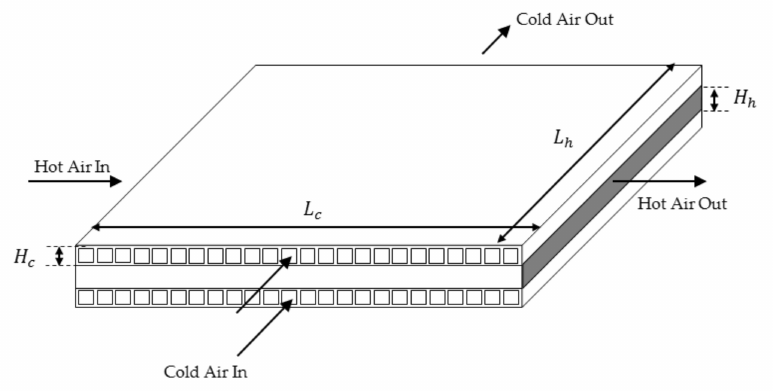
Figure 2. Structure of the plate-fin heat exchanger, showing the airflow direction ( L c , channel length for cold air; L h , channel length for hot air; H c , channel height for cold air; H h , channel height for hot